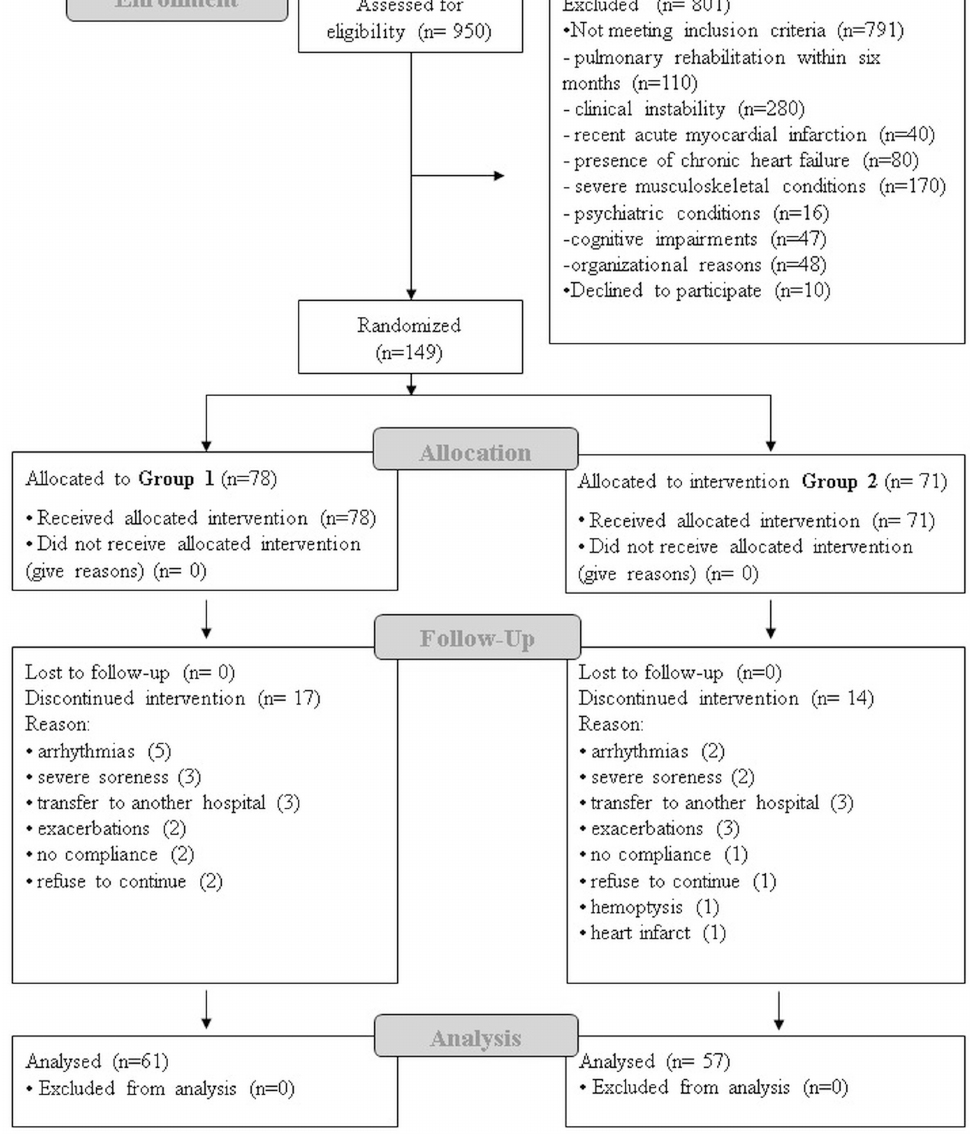
Figure 1. CONSORT Trial flow of the study. Table 1 describes the anthropometric and clinical characteristics of the patients studied. Table 1. Anthropometric and clinical characteristics of included patients. MEASURES